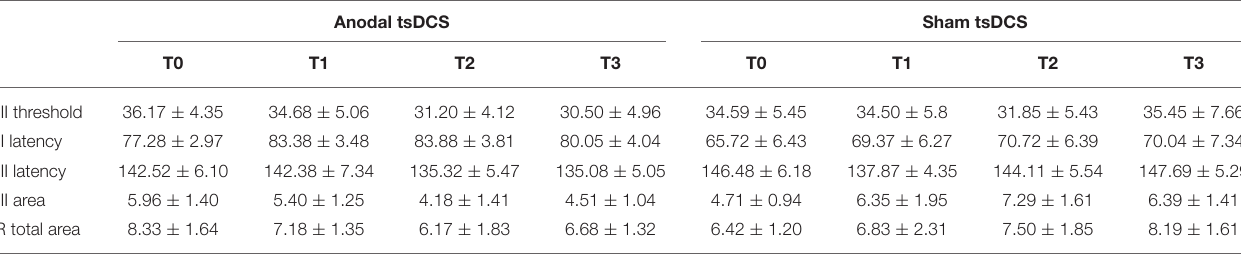
TABLE 2 | Neurophysiological